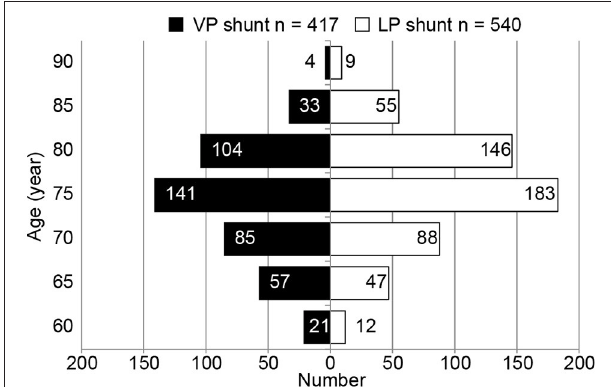
FIGURE 3 | Histogram of shunt intervention (ventriculoperitoneal shunt vs. lumboperitoneal shunt) in idiopathic normal pressure hydrocephalus patients. Data represent the number of patients receiving shunt interventions (ventriculoperitoneal [VP] shunt, n = 417; lumboperitoneal [LP] shunt, n = 540). Patients were stratified by age (5-year age groups) to compare the two different shunt